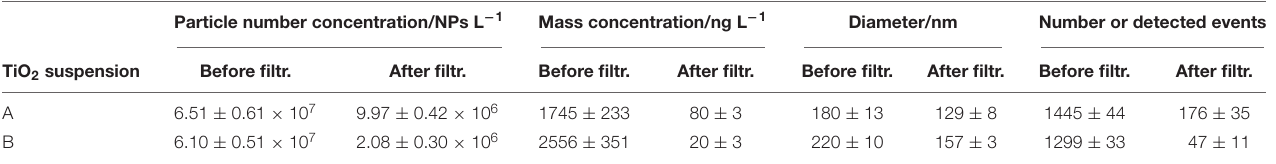
TABLE 3 | Comparison of median diameters, particle number concentrations, mass concentrations, and number of detected events obtained for two TiO 2 suspensions before and after filtration through a 0.45- µ m pore size filter. Particle number concentration/NPs L −